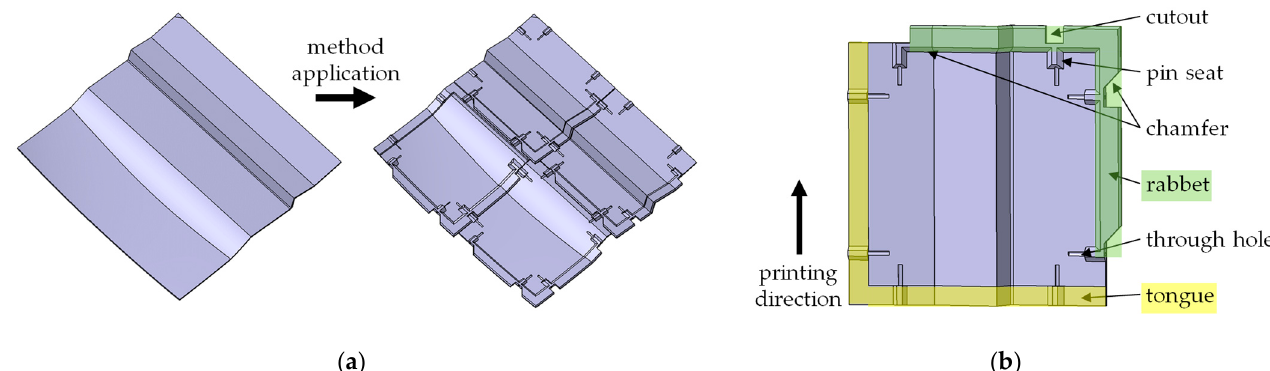
Figure 8. ( a ) Back side of the example and back side of the assembly after application of the method. ( b ) Design elements of a segment.